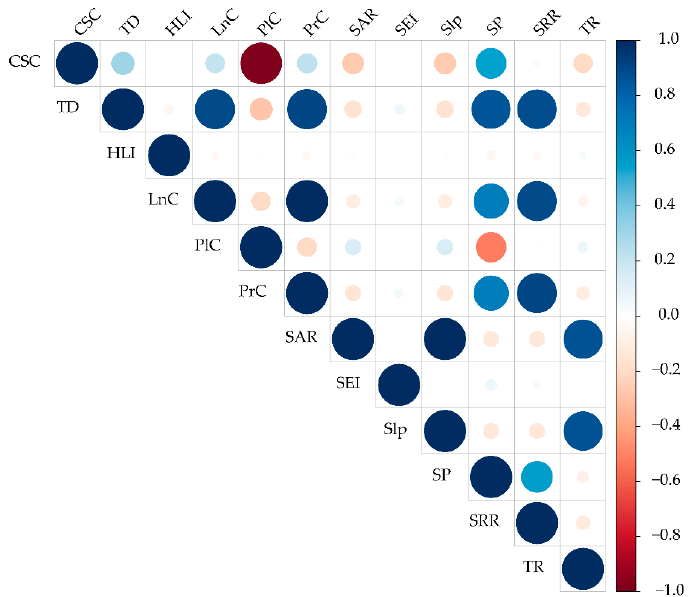
Figure 3. Correlation between a subset of terrain variables. Cross sectional curvature (CSC), topographic dissection (Diss), longitudinal curvature (LnC), planform curvature (PLC), slope position (SP), surface relief ratio (SRR) and terrain roughness (TR) were calculated using a 7-cell radius circular window. Both the size and color of the circle symbol represent the magnitude of correlation based on Spearman’s rho.